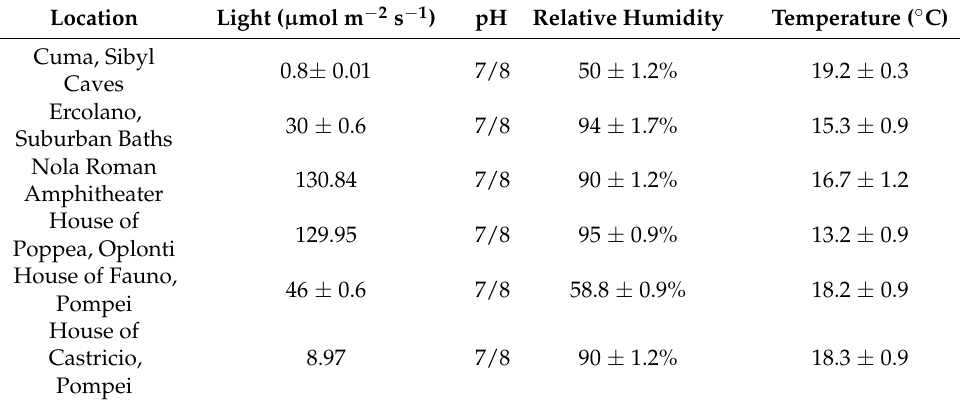
Table 1. Values of environmental parameters (light, pH, relative humidity, and temperature) at each sampling